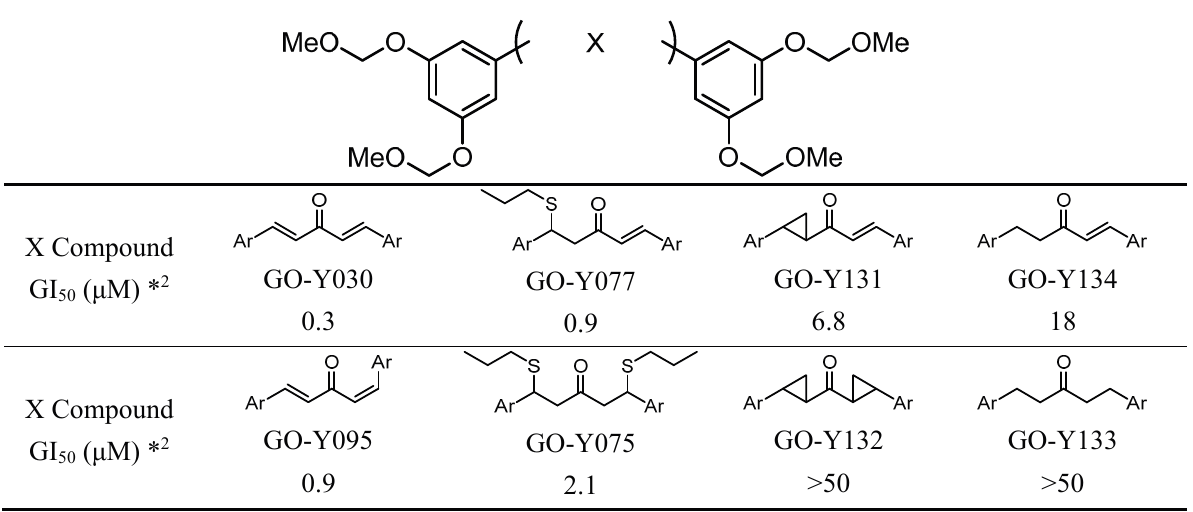
Table 2. SAR of central tether